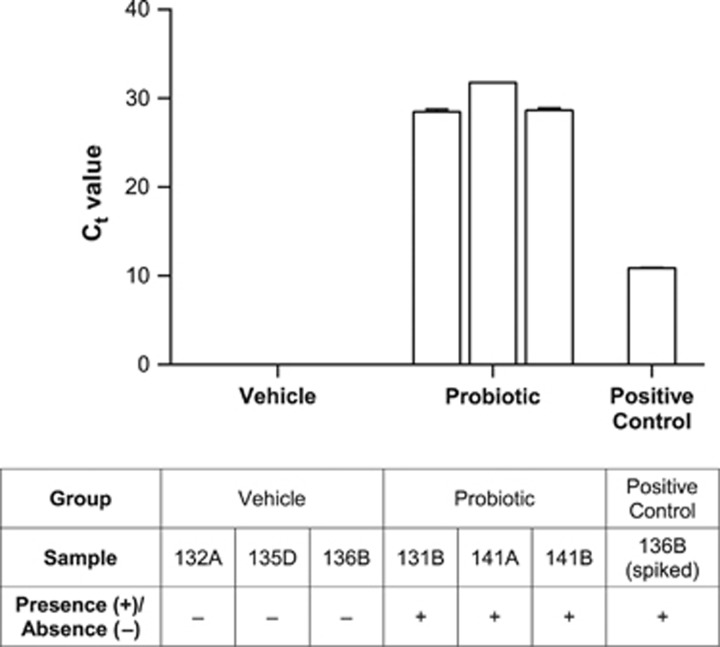
Mean (±s.d.) threshold cycle (Ct values) for amplification of L. rhamnosus strain R0011 from stomach milk samples of vehicle-exposed (n=3) and probiotic-exposed (n=3) maternally separated pups at P7, and a positive control prepared from a vehicle-exposed sample spiked with probiotic solution. Ct values for all samples in the vehicle-exposed group were undetermined (includes Ct values >33 or undetermined by the software).